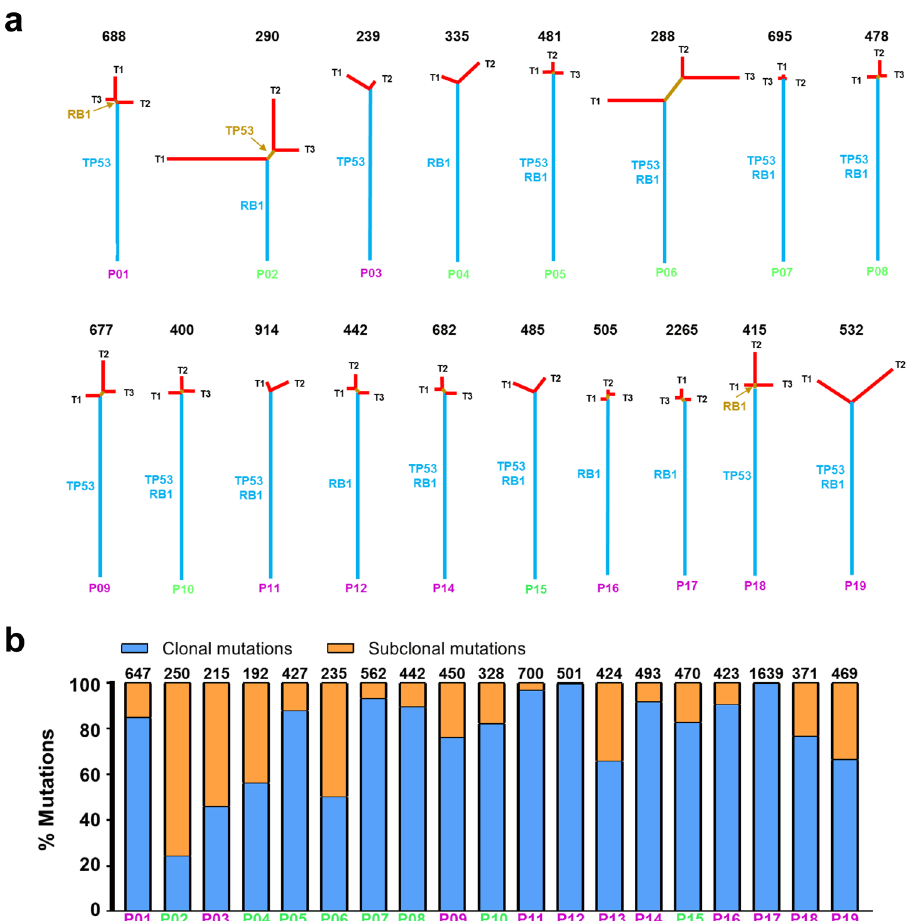
Fig. 1 Genomic intratumor heterogeneity (ITH) and clonal architecture of limited-stage small-cell lung cancers (LS-SCLCs). a Phylogenetic trees of 18 limited-stage SCLC tumors (LS-SCLCs) with multi-region whole-exome sequencing (WES). Blue, brown and red lines represent trunk, branch, and private mutations, respectively. The length of trunk (blue), branch (brown), and private branch (red) is proportional to the numbers of mutations shared by 3, 2, or 1 tumor regions. The total number of mutations is listed above the phylogenetic tree of each tumor. TP53 and RB1 mutations are mapped to the phylogenetic trees as indicated. b Global clonal architecture of SCLC at tumor level. PyClone was run on merged bam fi les from different regions of the same tumors. Mutations were classi fi ed as clonal (present in the cluster with the highest cellular prevalence, blue) or subclonal (orange) in each tumor. The total number of mutations in each tumor is listed on the top of each bar. Note: the numbers of mutations in each tumor are less than those in phylogenetic analysis as the clonal status of some mutations could not be inferred by PyClone. Patient ID: purple = alive; green = deceased. Source data are provided as a Source Data fi